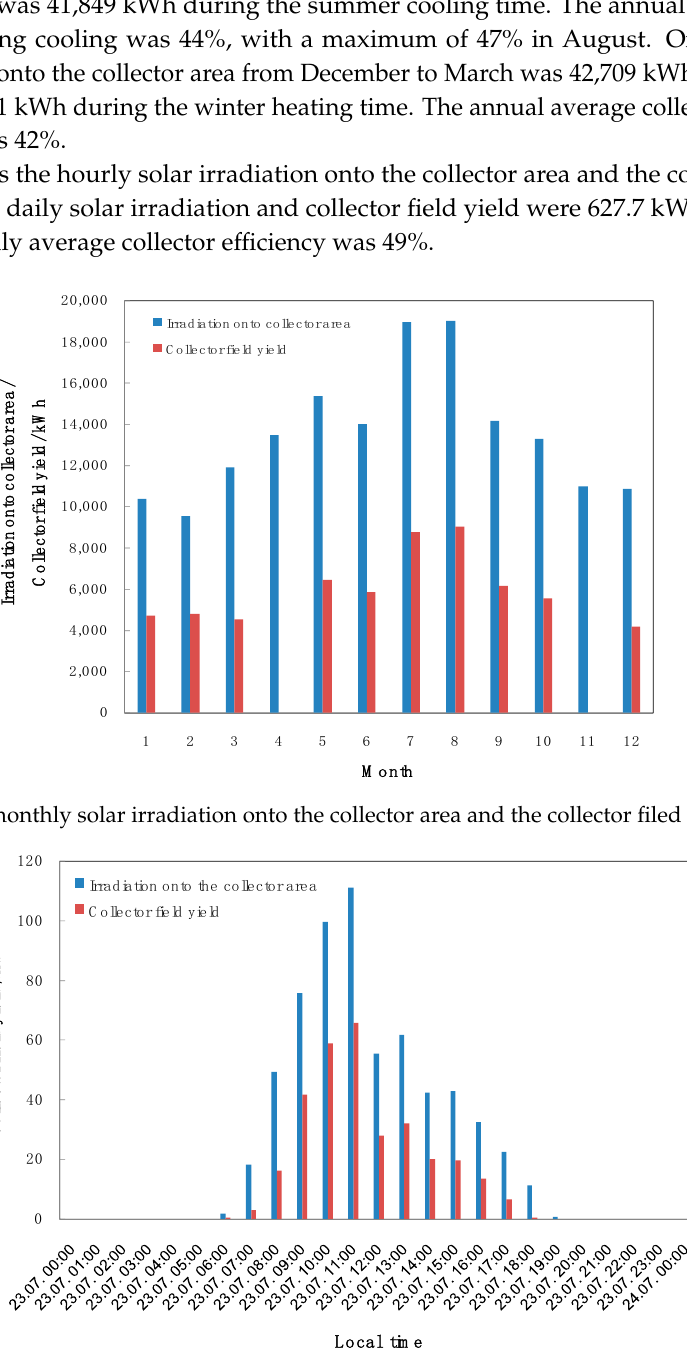
Figure 11. The hourly solar irradiation onto the collector area and the collector filed yield on 23 July 2018.